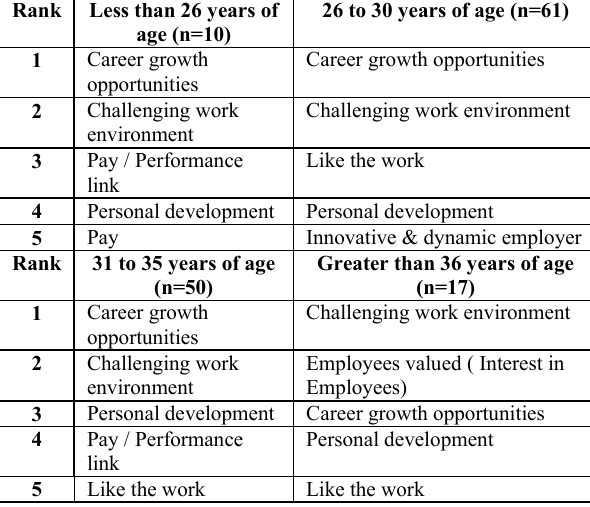
Table 4: The top five attributes for the four age